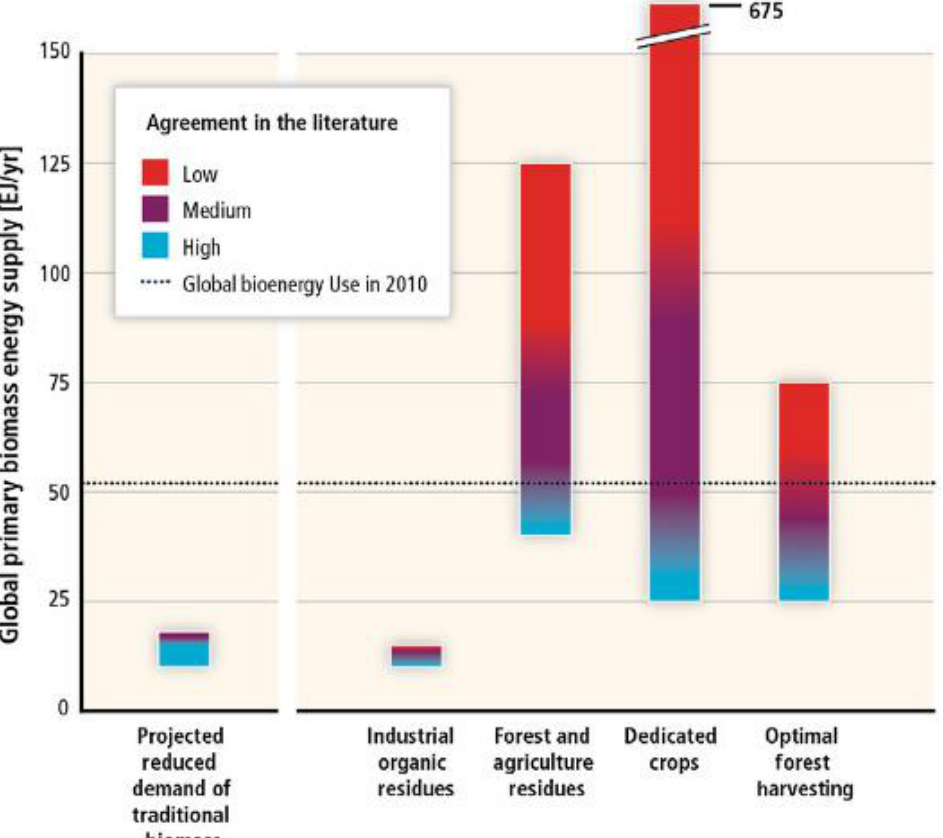
Figure 1. Global technical primary biomass potential for bioenergy by main resource category for the year 2050. The figure shows the ranges in the estimates by major resource category of the global technical primary-biomass potential for bioenergy. The color grading is intended to qualitatively show the degree of agreement in the estimates, from blue (all researchers agree that this level can be attained) to purple (medium agreement) to red (few researchers agree that this level can be attained) [8].